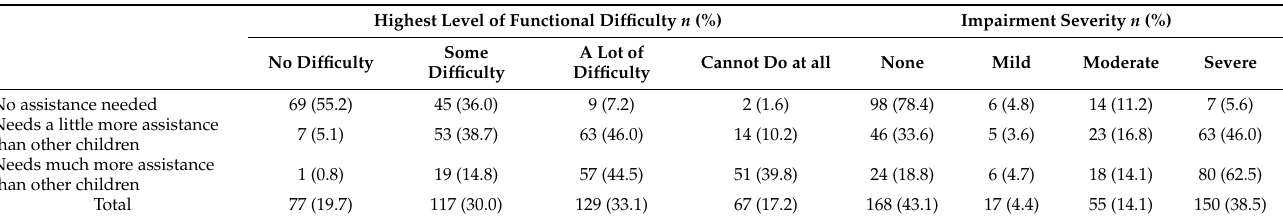
Table 2. Cross-tabulations between level of assistance required and highest level of functional difficulty (CFM response) and impairment